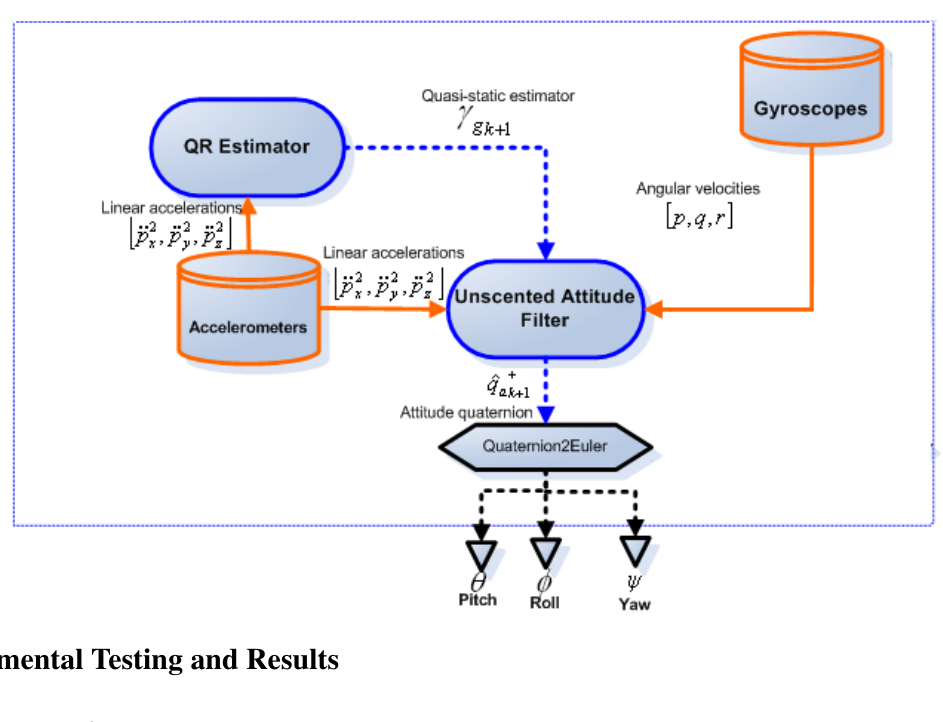
Figure 6. Sensor Fusion scheme on board the